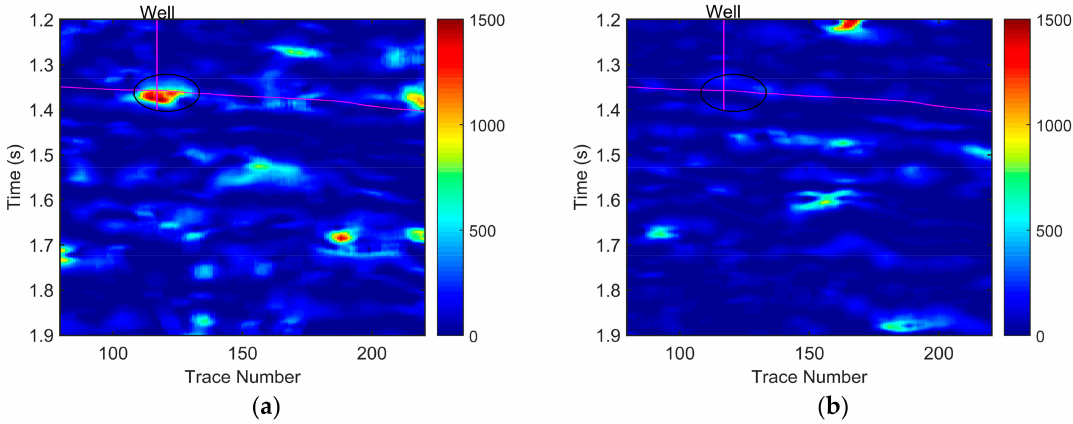
Figure 11. Constant frequency sections based on SSCWT ( a ) at 40 Hz and ( b ) at 50 Hz.